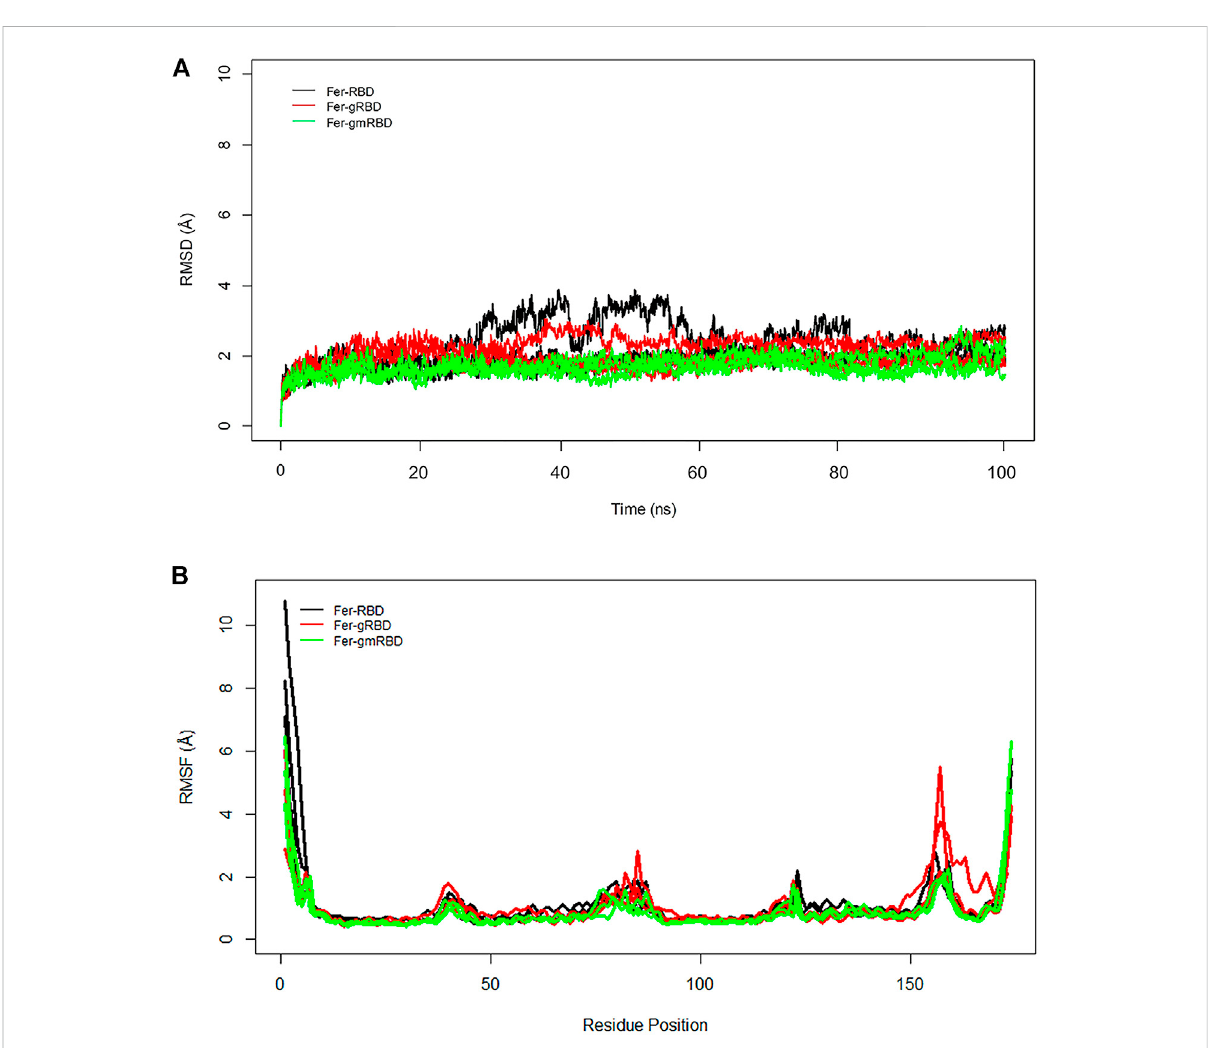
FIGURE 8 (A) RMSD of all systems is calculated for ferritin over 100 ns MD simulations. The structural distance of CA atoms calculated for all replicates of Fer-RBDfN, Fer-gRBDfN, and Fer-gmRBDfN systems are shown in black, red and green, respectively. (B) RMSF of all systems is calculated for ferritin over100nsMDsimulations.FluctuationsofCAatoms calculatedforallreplicatesofFer-RBDfN,Fer-gRBDfN, andFer-gmRBDfN systemsareshown in black, red, and green,